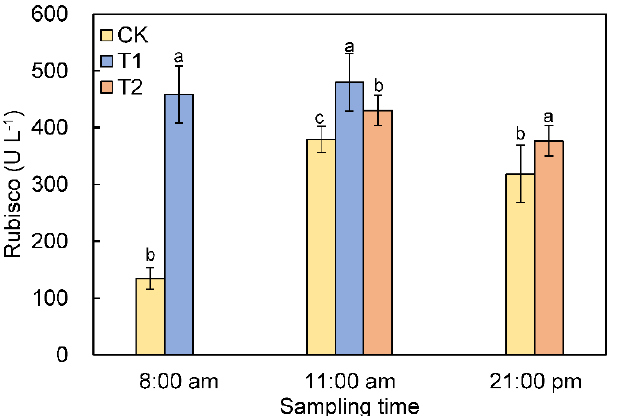
Figure 6. Rubisco activity in tomato leaves exposed to different LED light supplementation durations. Data are expressed as average values ( n = 3). Different lowercase letters indicate significant differences between treatments determined using Duncan’s multiple range test ( p < 0.05). Standard errors are indicated by bars. CK: no light supplementation or control; T1: light supplementation for 3 h in the morning; T2: light supplementation for 3 h in the evening.